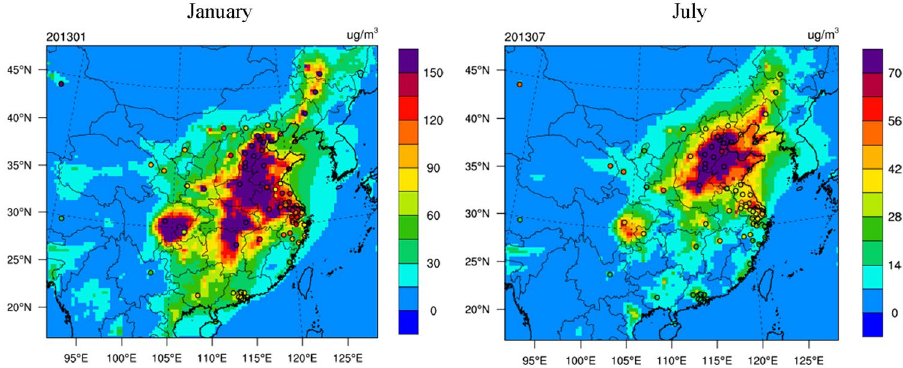
Figure 1. Observed (dots) and simulated (contours) monthly mean PM 2.5 concentrations in the BASE scenario in January (left panel) and July (right panel), 2013. This figure is produced using the NCAR Command